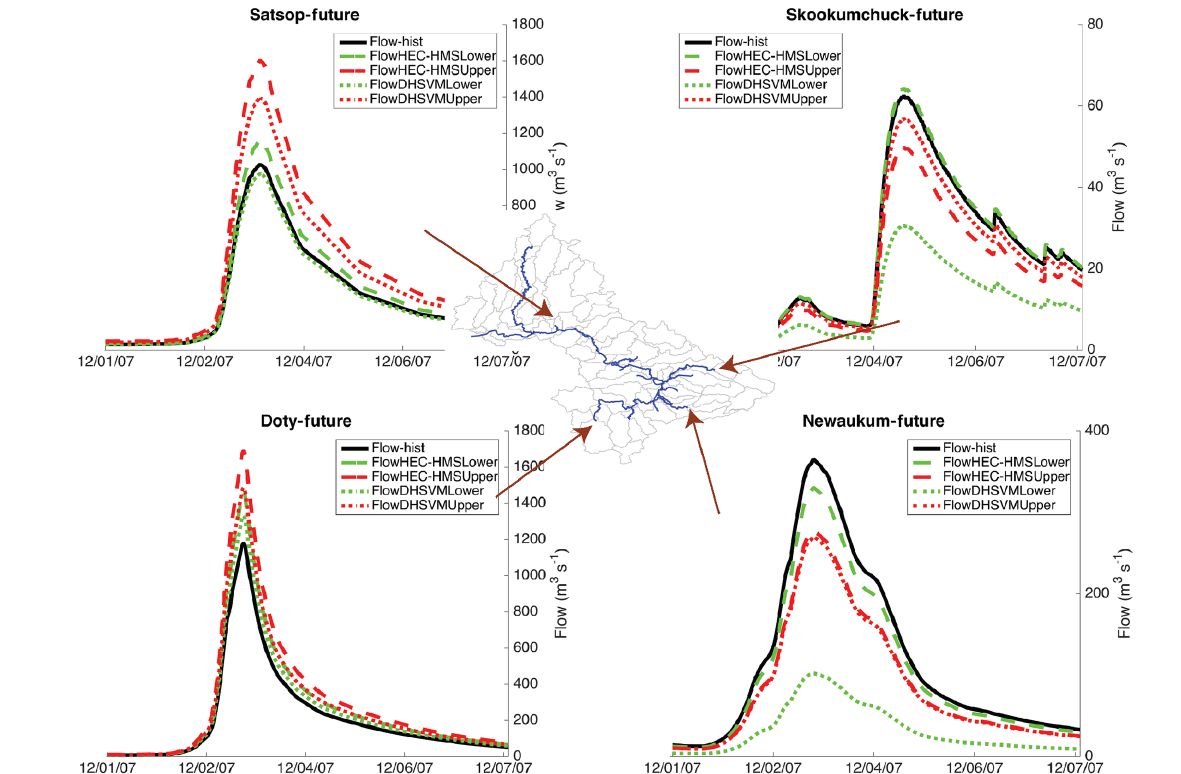
Figure 10. Streamflow hydrographs for the HEC-HMS-PGW upper scenario (dashed) and HEC-HMS-control (solid) for select sub-basins in the Chehalis. Table 3. Projected economic losses for the historical simulations (Base) and the upper and lower scenarios for the two hydrologic models. Values are in millions of US dollars (at 2008 rates). Values in parentheses represent